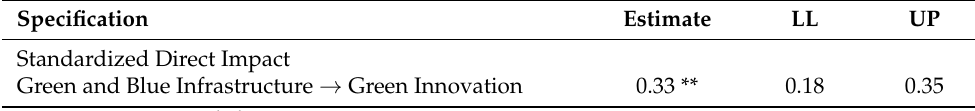
Table 3. Results of path analysis using structural equation